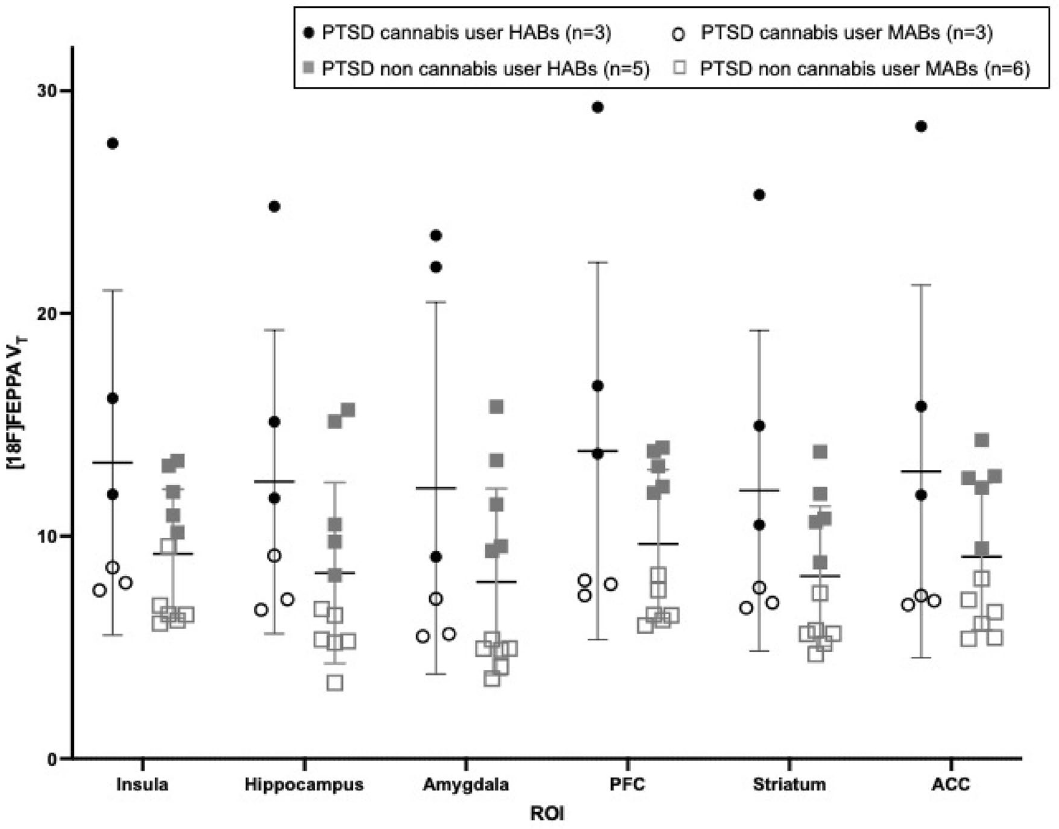
Figure 2. [ 18 F]FEPPA V T and cannabis use. [ 18 F]FEPPA V T between PTSD participants who regularly consume cannabis (n = 3 HABs [solid]/n = 3 MABs [outline]) and PTSD participants who are non-cannabis users (n = 5 HABs [solid]/n = 6 MABs [outline]). PTSD cannabis users have 41.6% higher TSPO binding compared to PTSD participants who do not use cannabis (F (1,14) = 4.759, p =